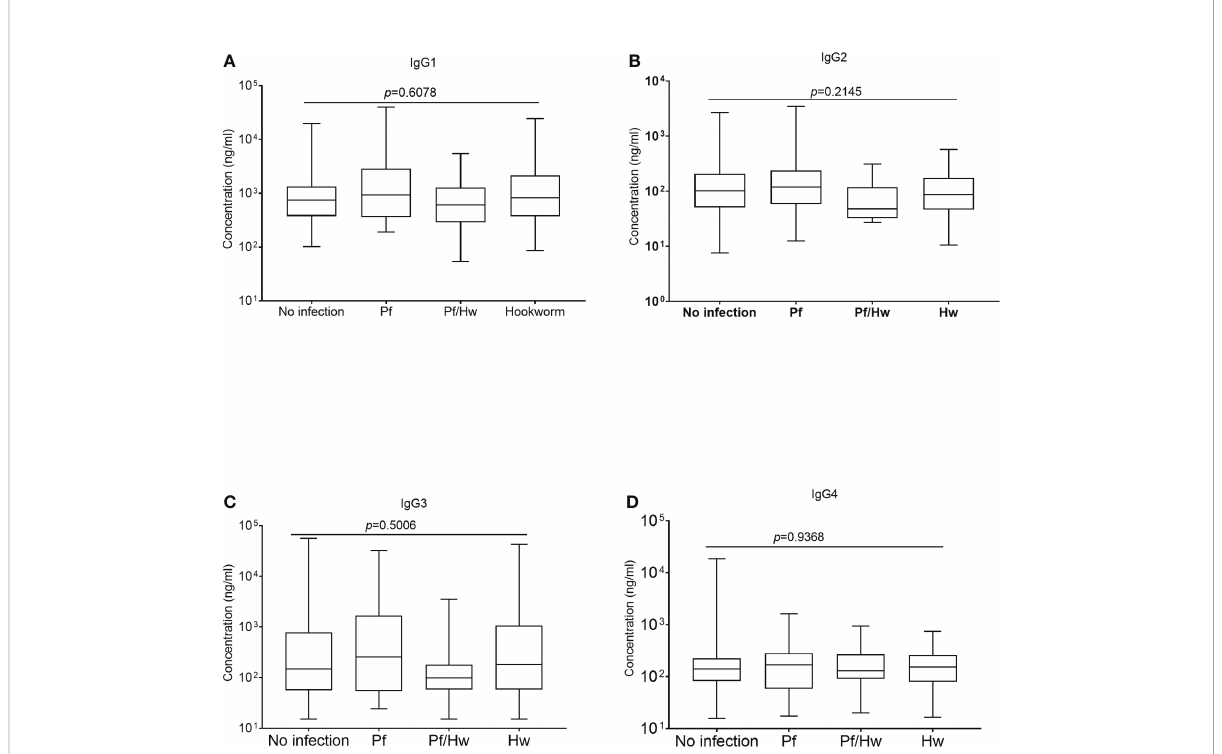
FIGURE 3 Effect of Hookworm infection on levels of GMZ2-speci fi c IgG subclasses Each box plot represents the median value with the interquartile range, while the whiskers represent the maximum values of antibody concentration in a particular group. Levels of IgG1, IgG2, IgG3 and IgG4 in the various groups are presented in Plots (A-D) ,